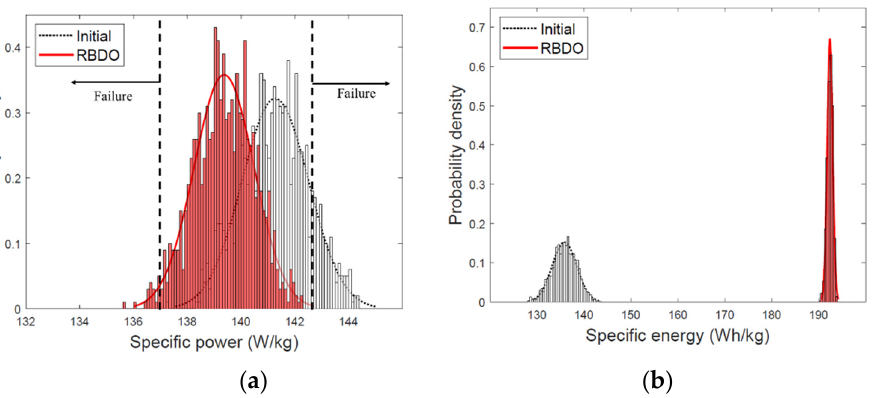
Figure 6. Probability distribution of the initial design and design optimized through the reliability- based design optimization (RBDO) ( a ) specific power; ( b ) specific energy.